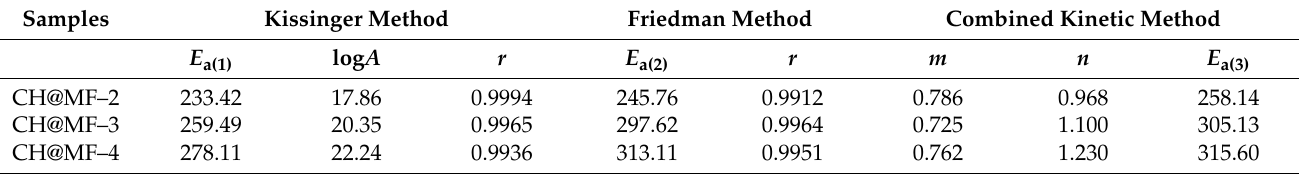
Table 4. The kinetic parameters for nonisothermal decomposition of the CH@MF composites. Samples Kissinger Method Friedman Method Combined Kinetic Method